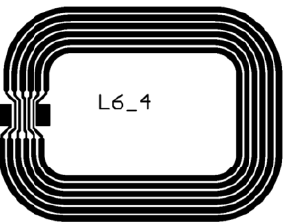
Figure 2. High frequency RFID antenna design (L6_4), designed by IMEC as described by [54]